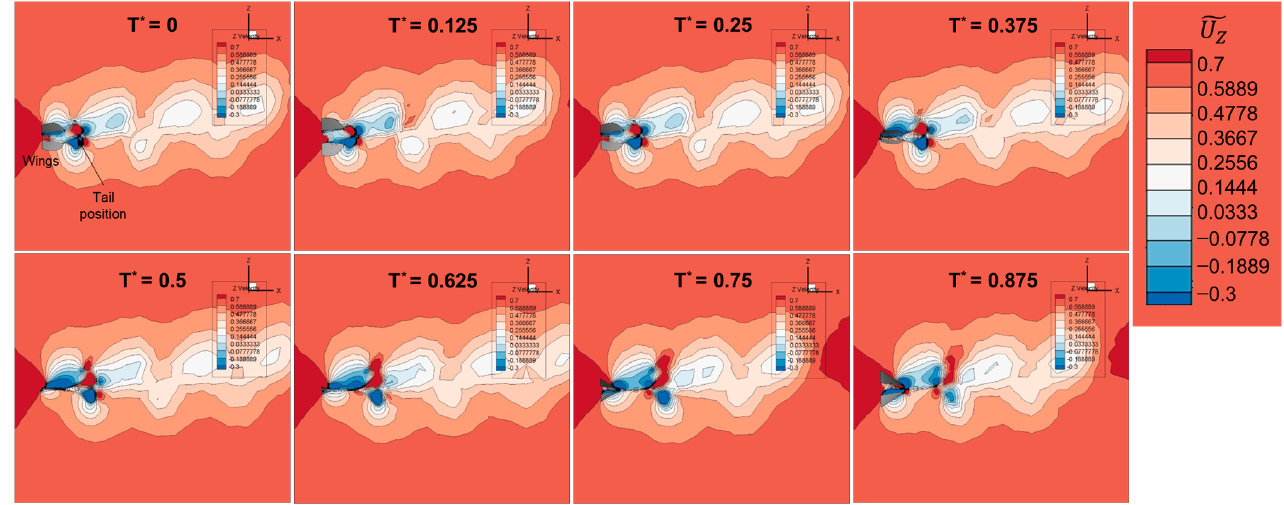
Figure 24. Z-velocity distribution in the section of y = 0.175 span.